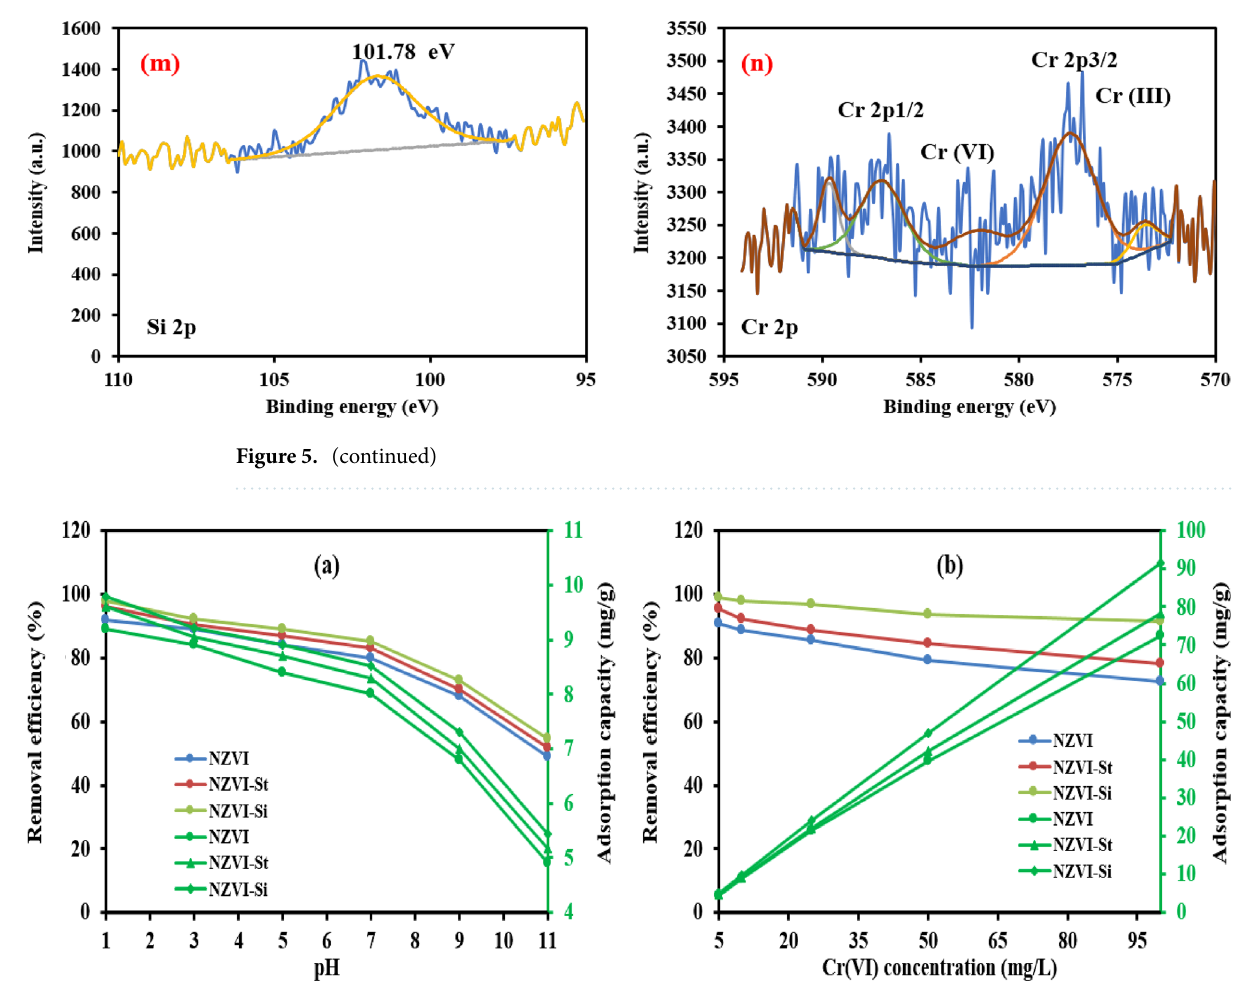
Figure 6. ( a ) Effect of pH and ( b ) Effect of initial Cr(VI) on the removal efficiency of Cr(VI) and adsorption capacity of synthesized